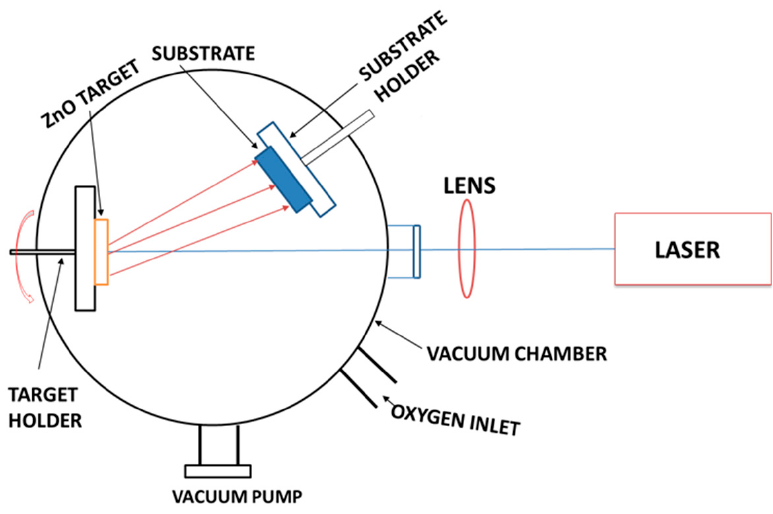
Figure 7. Pulsed laser deposition (PLD) setup used for synthesis of vertically aligned ZnO nanorods (VAZO).